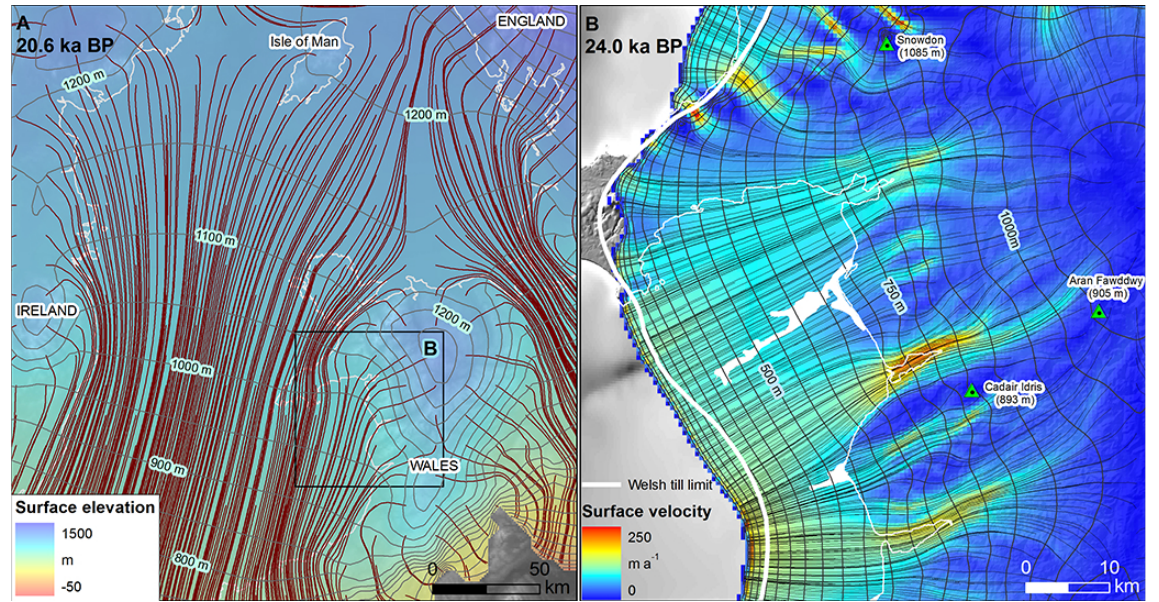
Figure 5. (A) Numerically modelled flowlines in the Irish Sea Basin and Welsh domain during the Last Glacial Maximum (LGM). Data are taken from the median experiment E109b8 by Hubbard et al. (2009). (B) Flowlines of the independently modelled Welsh Ice Cap by Patton et al. (2013a). The limit of Welsh till in Cardigan Bay was delimited by Garrard and Dobson